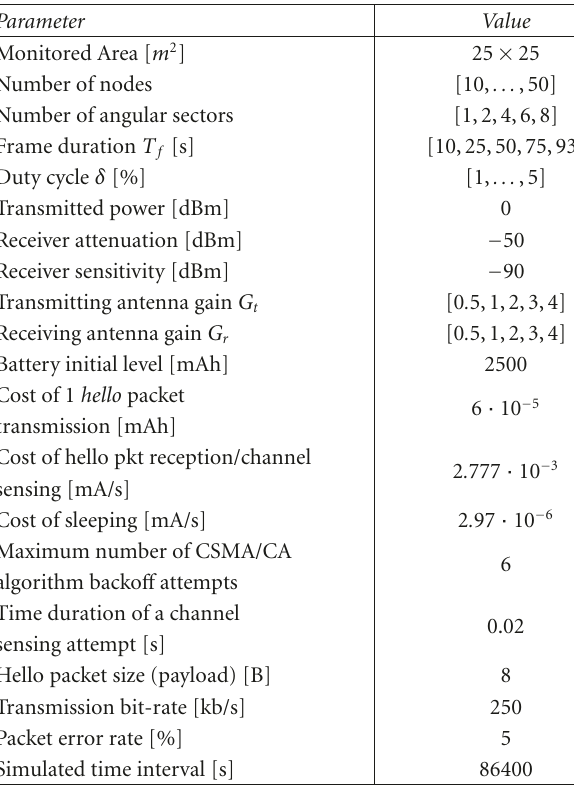
Table 1: Parameters values adopted within the numerical simula- tion campaign.